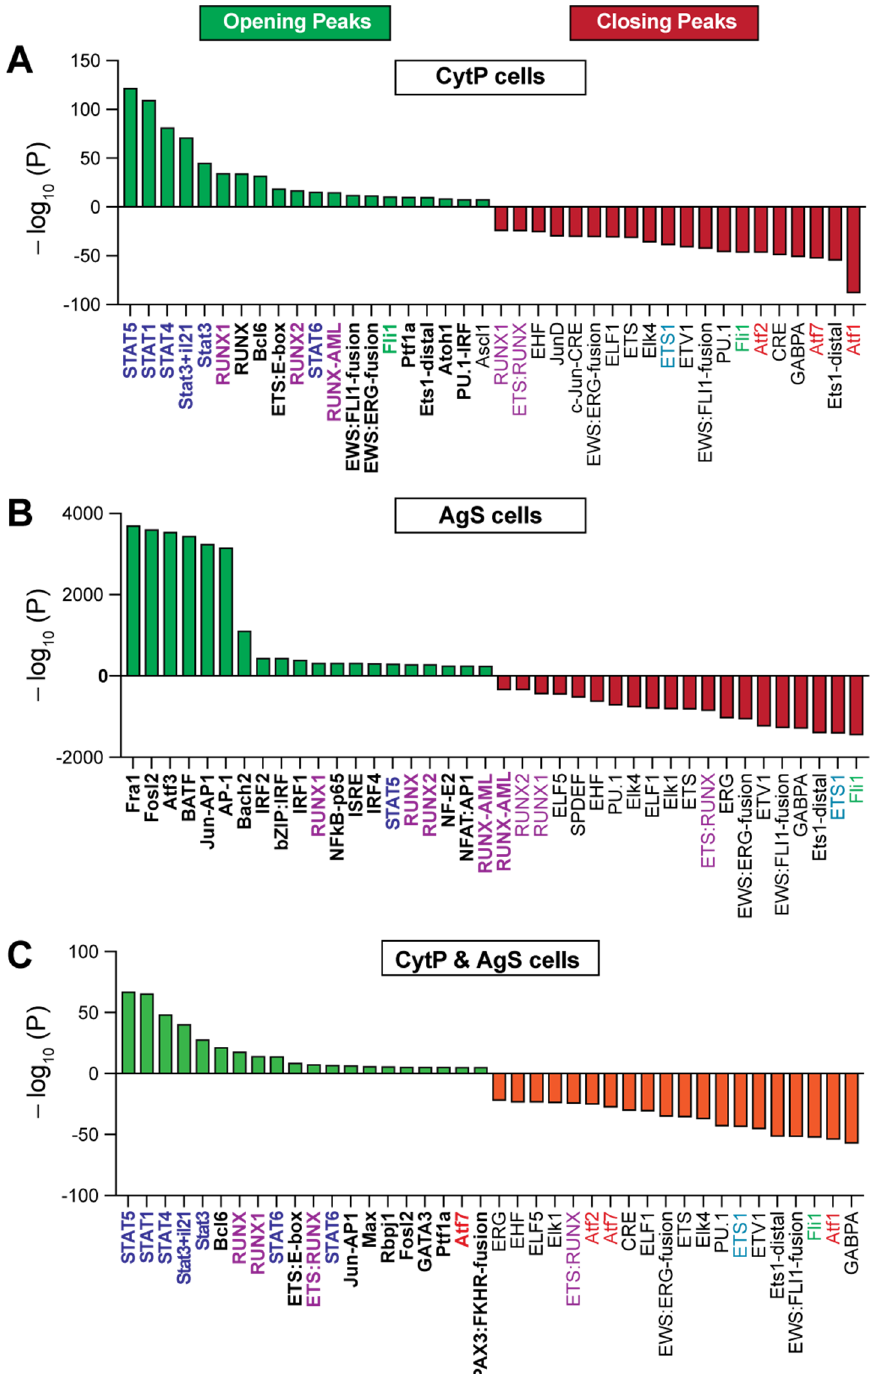
Figure 5. Enrichment of transcription factor binding motifs in cytokine-primed and Ag-stimulated cells. Top twenty transcription factor binding motifs found near the opening and closing peaks of CytP ( A ) and AgS ( B ) cells. Motifs found near the opening and closing peaks of both CytP and AgS cells are shown in ( C ).